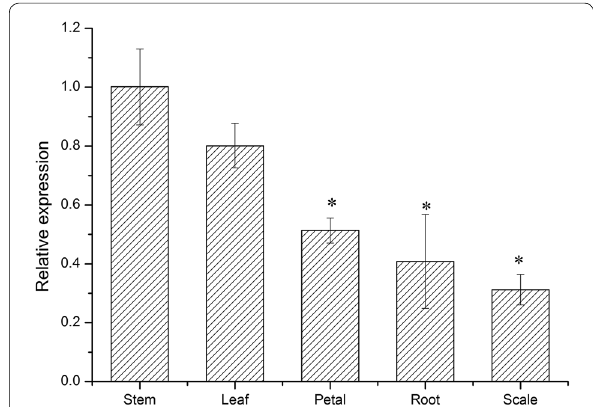
Fig. 5 Tissue-specific expression of LhSorTGA2 in oriental hybrid lily cv. Sorbonne. The expression of LhSorTGA2 in stem was used as calibrator (designated as 1.0) to determine the relative expres- sion of the target gene in different tissues. Relative expression was calculated using REST 2009 software, and the values were presented as mean standard deviation (SD) for three replicates. Bars labeled ± with an asterisk indicate significant differences from the calibrator at P < 0.05 (the REST statistical randomization